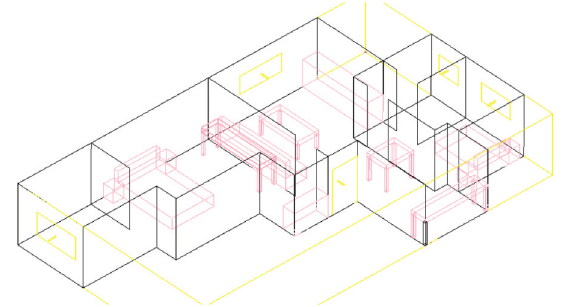
Figure 2: Model of house type B. Table 1: Size table of type A furniture.